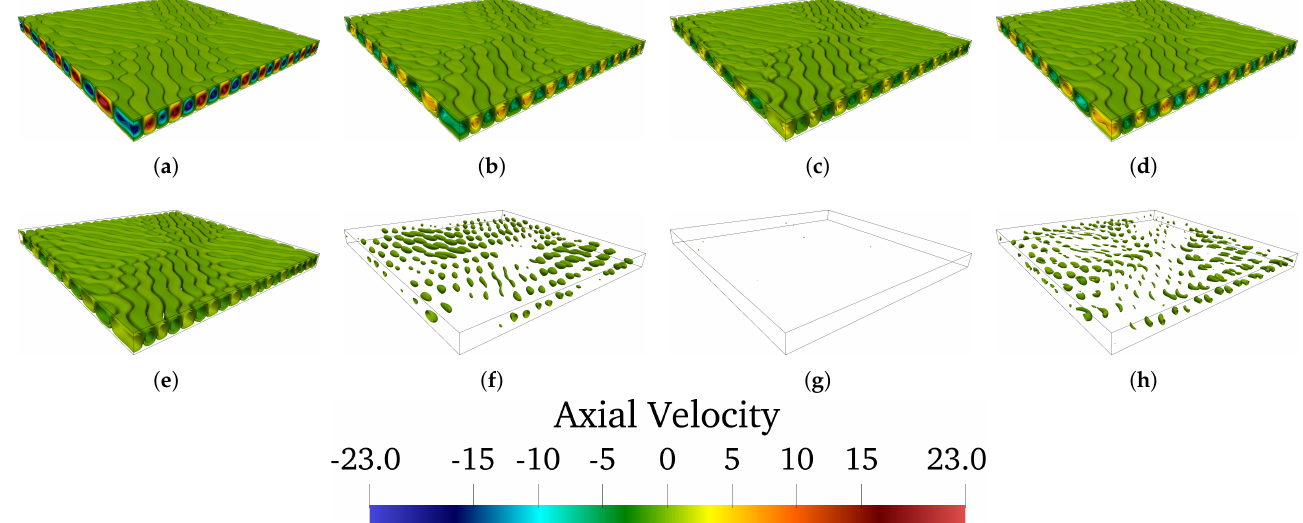
Figure 4. Thermovibrational convection in a layer of FENE-CR fluid delimited by differentially heated solid walls (snapshots of the isosurfaces of the vertical component of velocity evenly distributed over the interval I 1 ). Pr g = 8, Ω = 25, Ra ω = 4000, ξ = 0.5, ϑ = 0.1, sinusoidal